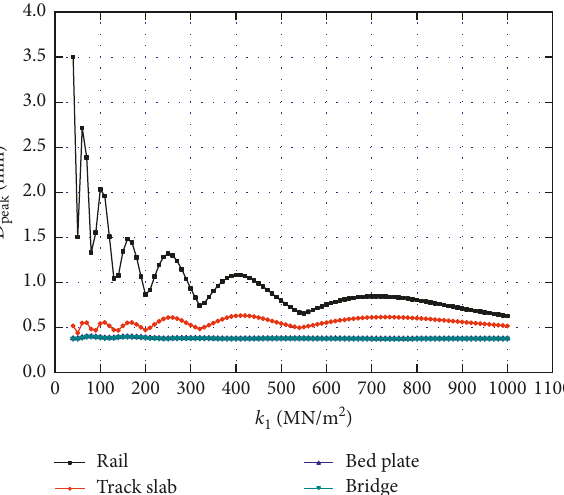
Figure 8: The maximum dynamic deflections of the rail, track plate, base plate, and bridge corresponding to different stiffnesses of the sliding